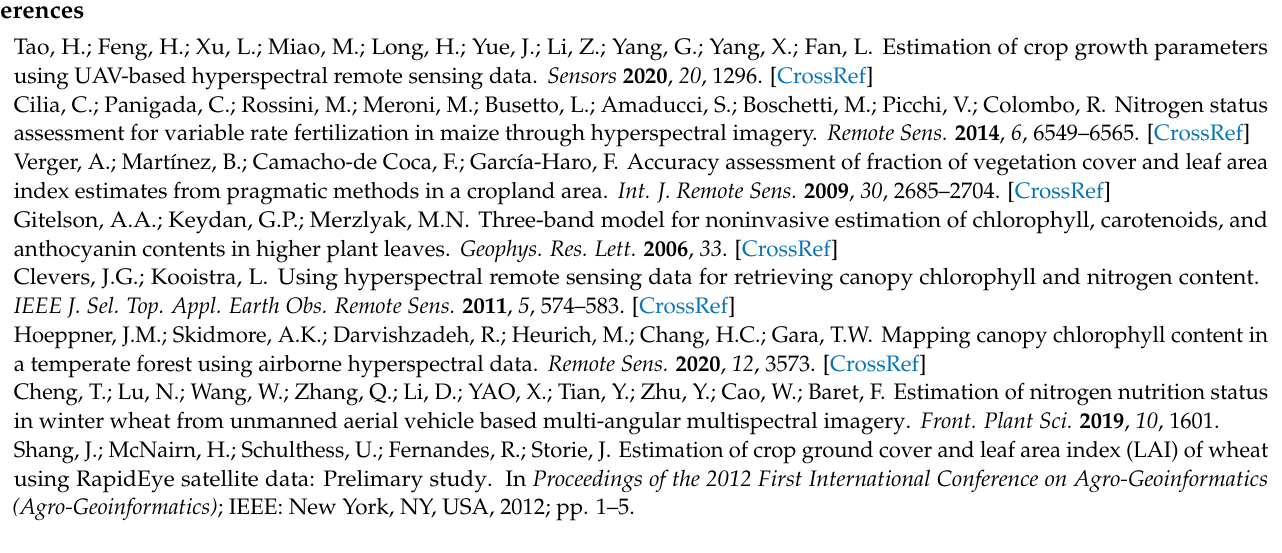
when sharing the same